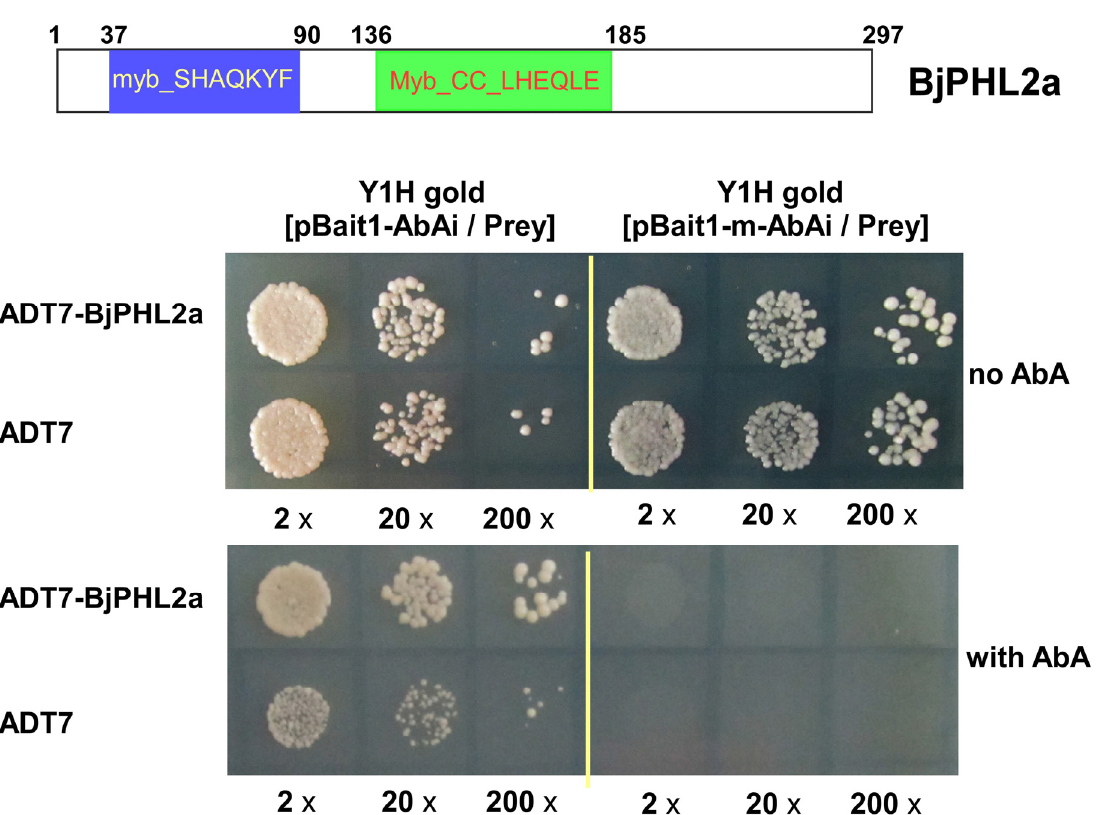
Figure 7. BjPHL2a interacts with the Wbl-4 element from BjCHI1 promoter. ( A ) Schematic diagrams of BjPHL2a . The deduced 297 amino acids and the putative two MYB domains (in bold) of BjPHL2a . The myb_DNA binding motif (myb_SHAQKYF) is shown in the blue box; the MYB-CC domain (Myb_CC_LHEQLE) is shown in the green box. The numbers above the box indicate the amino acid positions in BjPHL2a . ( B ) Yeast one-hybrid analysis of BjPHL2a . The bait-reporter yeast strain Y1Hgold [pBait1-AbAi] (Bait) and bait mutated strains Y1Hgold [pBait1-m-AbAi] (Bait-m) expressing the indicated plasmids were grown on SD/-Leu (no AbA) and SD/-Leu/+AbA 550 (with AbA) agar plates, respectively. Yeast cells were incubated until the optical density at 600 nm reached 0.8 and then were diluted 2-fold (2 × ), 20-fold (20 × ), or 200-fold (200 × ) and used for